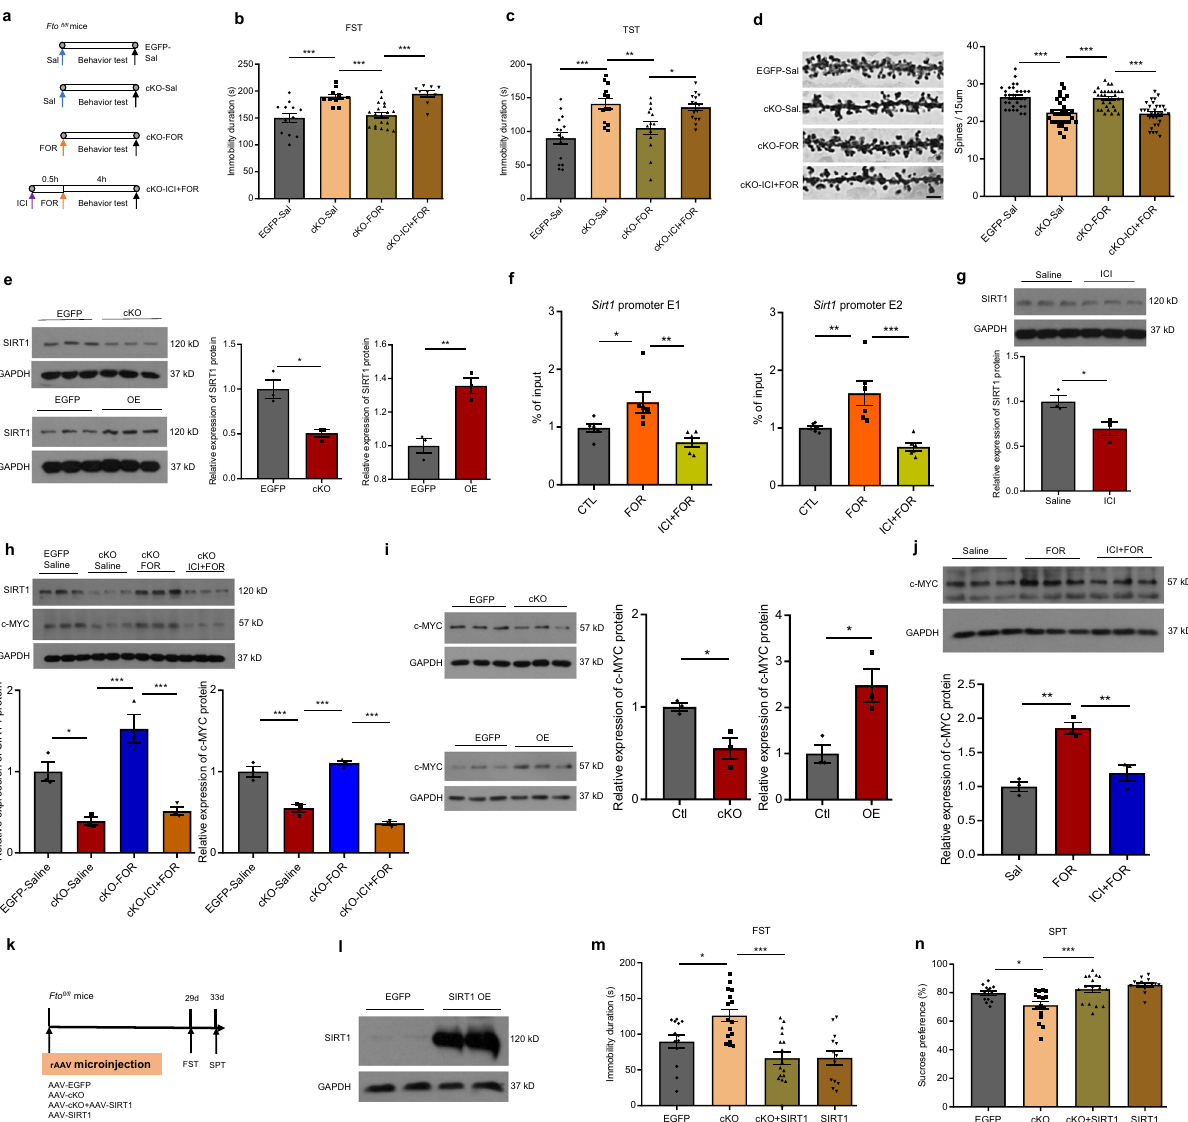
Fig. 5 ADRB2 stimulation rescues depression-like behaviors and spine loss induced by hippocampal FTO de fi ciency. a Schematics of the experimental design. Sal, Saline; FOR, formoterol, a speci fi c Adrb2 agonist; ICI, ICI 118,551, a speci fi c Adrb2 antagonist. b FST in one group of cKO mice. EGFP-Sal, n = 12; cKO-Sal, n = 11; cKO-FOR, n = 19; cKO-ICI + FOR, n = 9. EGFP-Sal vs. cKO-Sal, p = 0.0003; cKO-Sal vs. cKO-FOR, p = 0.0004, cKO-FOR vs.